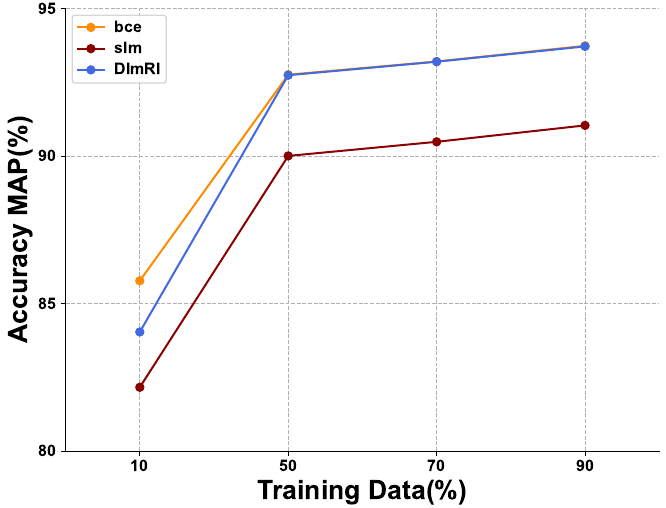
Figure 2. The figure shows the MAP score (%) of three different loss methods on VOC2007 with full labels. The orange line indicates the accuracy rate using BCE with Logits Loss (bce): the red line indicates the accuracy rate using MultiLabel SoftMargin Loss (slm); and the blue line indicates the accuracy rate using our DlmRl.